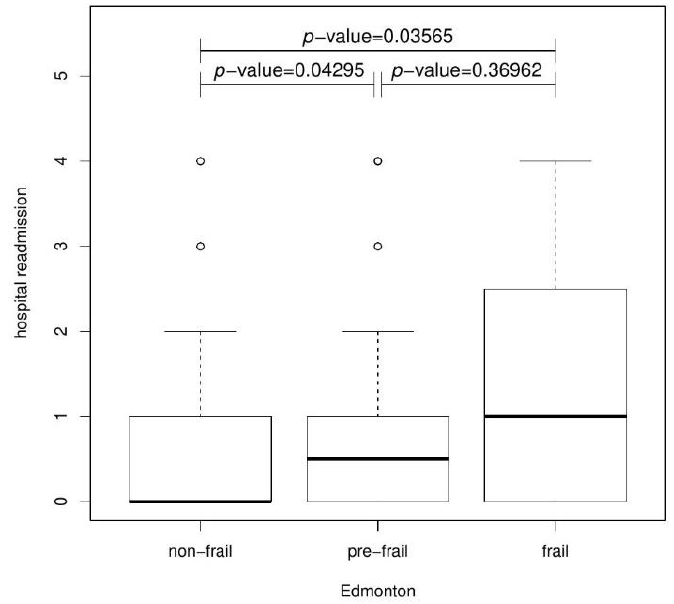
Figure 7. Boxplot presenting the relationship between Hospital readmission and Edmonton after 12 months.